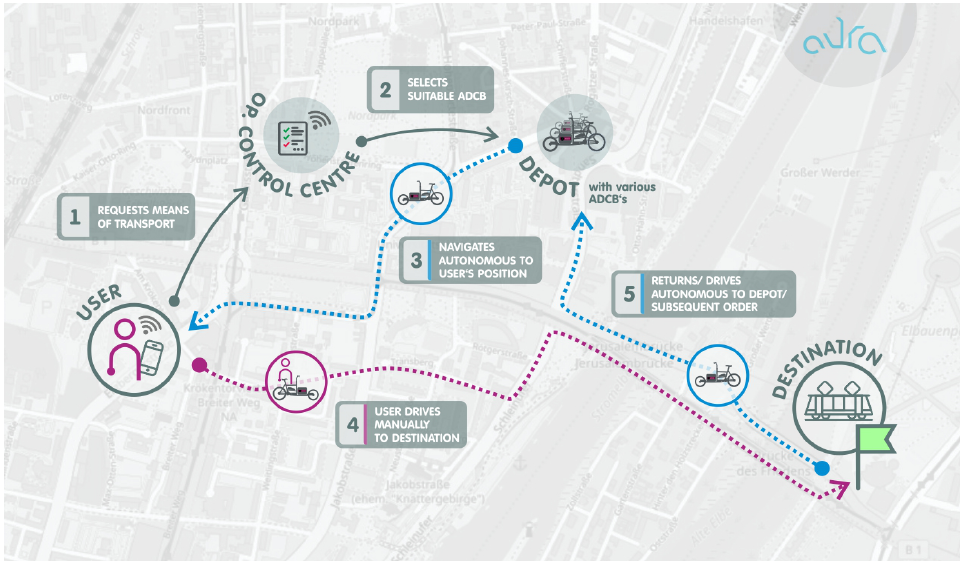
Figure 1. The basic concept of OSABS